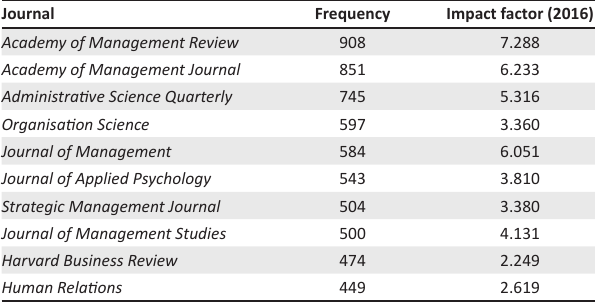
TABLE 10: The Top 10 journals of the references.